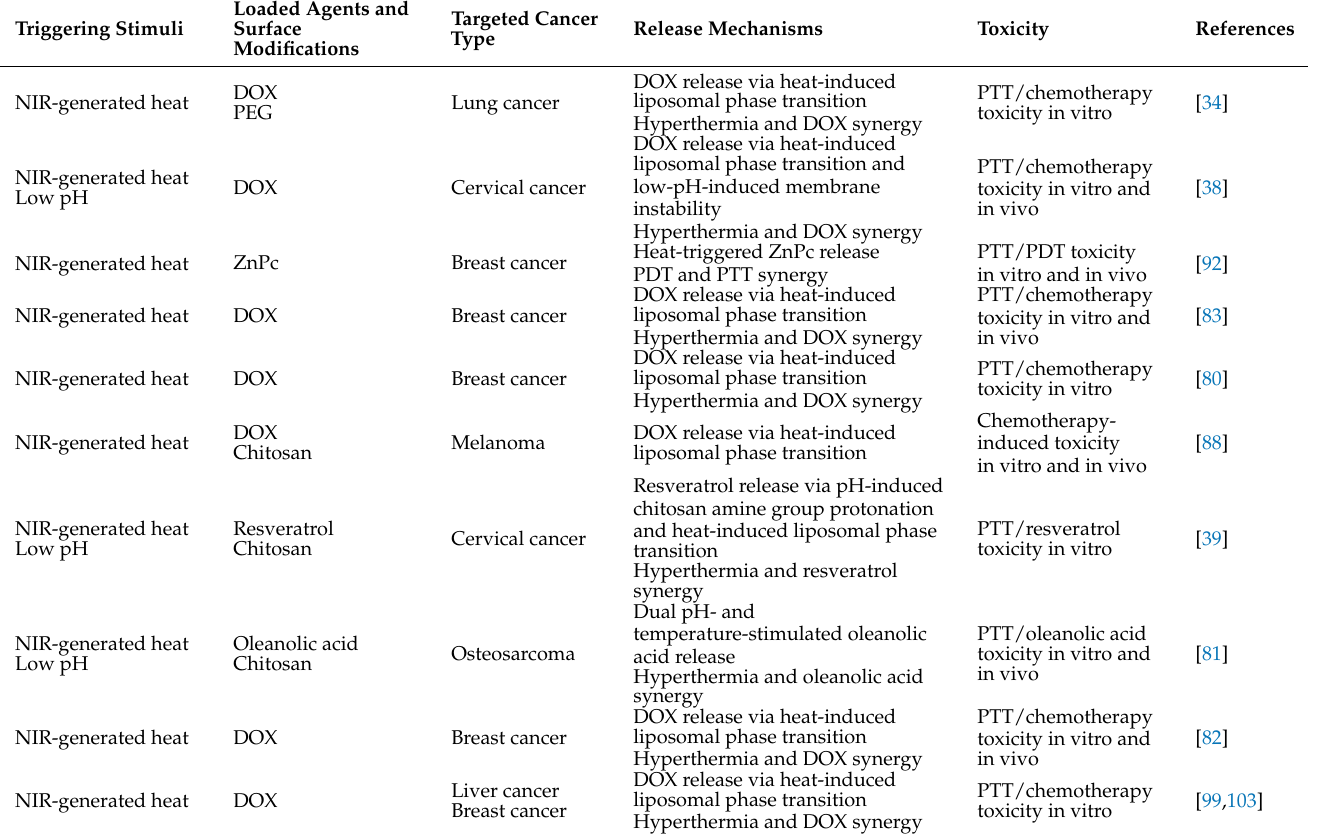
Table 1. Multimodal GNP–liposome nanohybrids for cancer